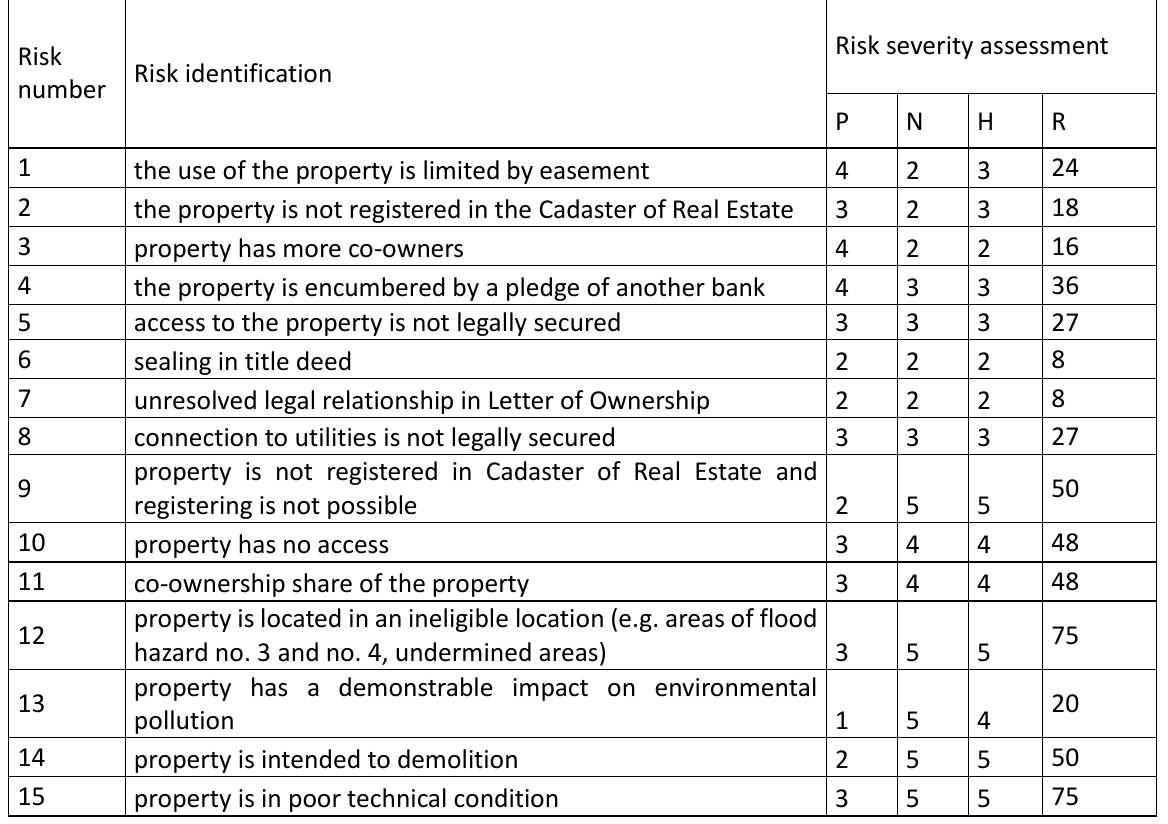
Table 3 - Risk identification and assessment (own